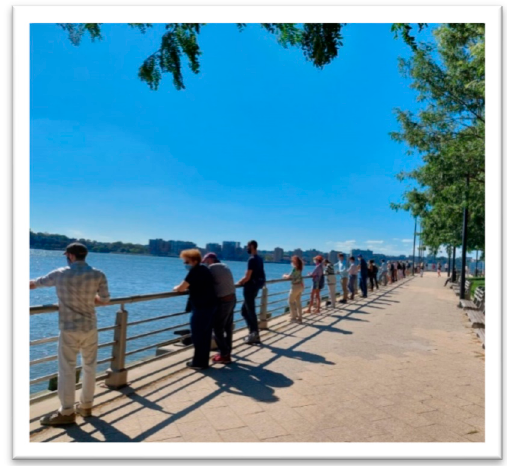
Figure 1. Tashlich at Hudson River,